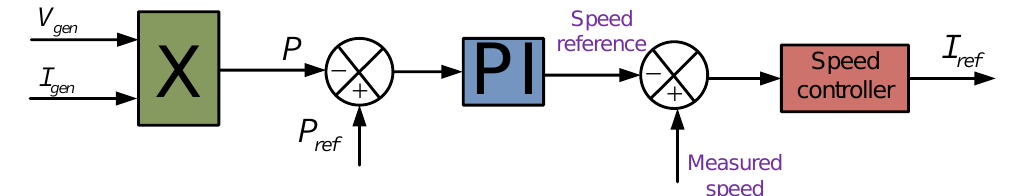
Figure 4. Power reference based